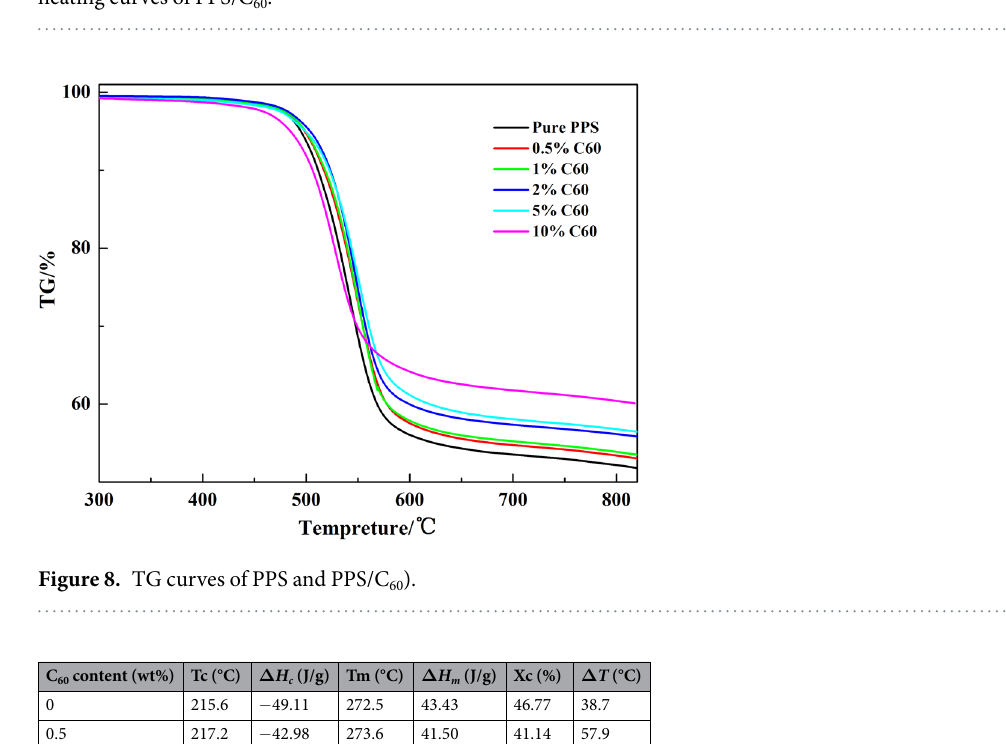
Figure 7. DSC thermograms obtained at a rate of 10 °C/min: ( a ) DSC cooling curves of PPS/C 60 ; ( b ) DSC heating curves of PPS/C 60 .